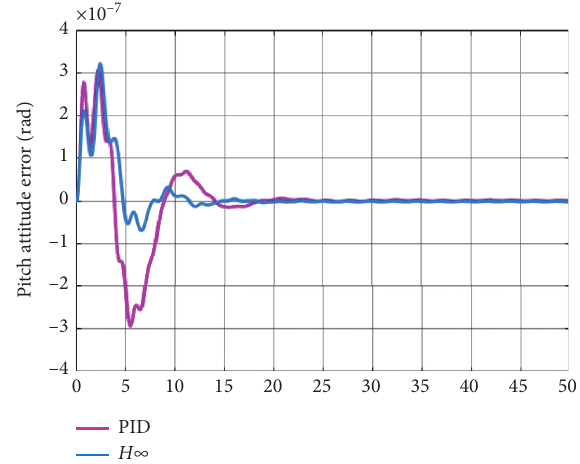
Figure 11: Time responses of the system with different